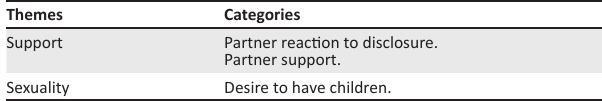
TABLE 2: Themes and categories generated from the study. Themes Categories